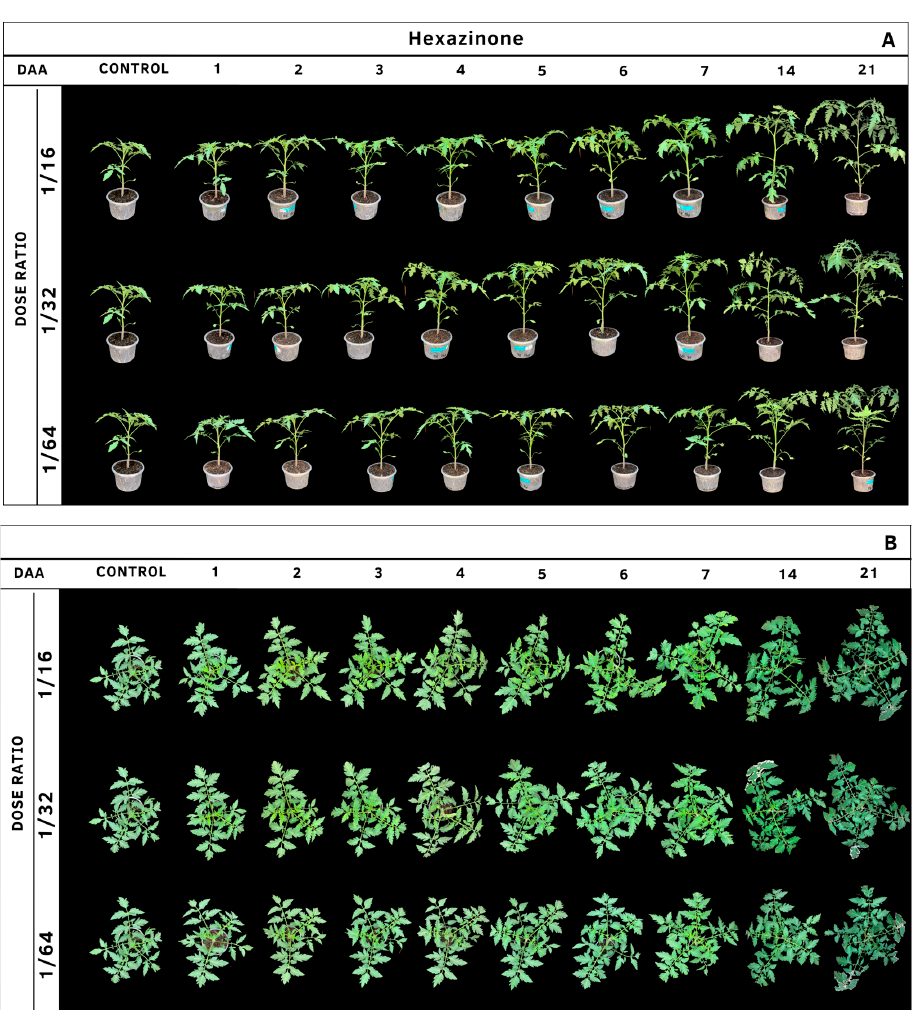
Figure 11. Symptoms evolution in tomato plants due to simulated hexazinone drift at dose ratios 1/16D, 1/32D, and 1/64D (24.75, 12.38, and 6.9 g a.i. ha − 1 , respectively) of the recommended dose (D). Evaluations were made from 1 to 7, 14, and 21 days after application (DAA). Front view ( A ) and top view ( B ) of tomato plants a ff ected by simulated drift.